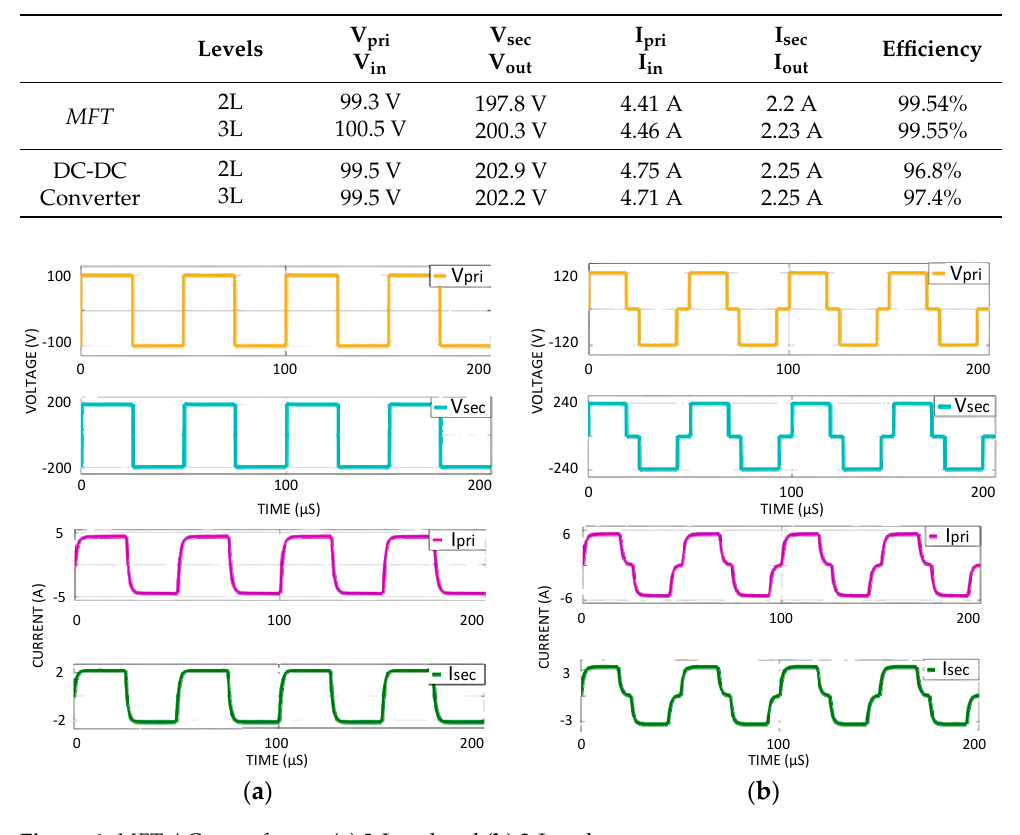
Figure 6. MFT AC waveforms: ( a ) 2-Level and ( b ) 3-Level.